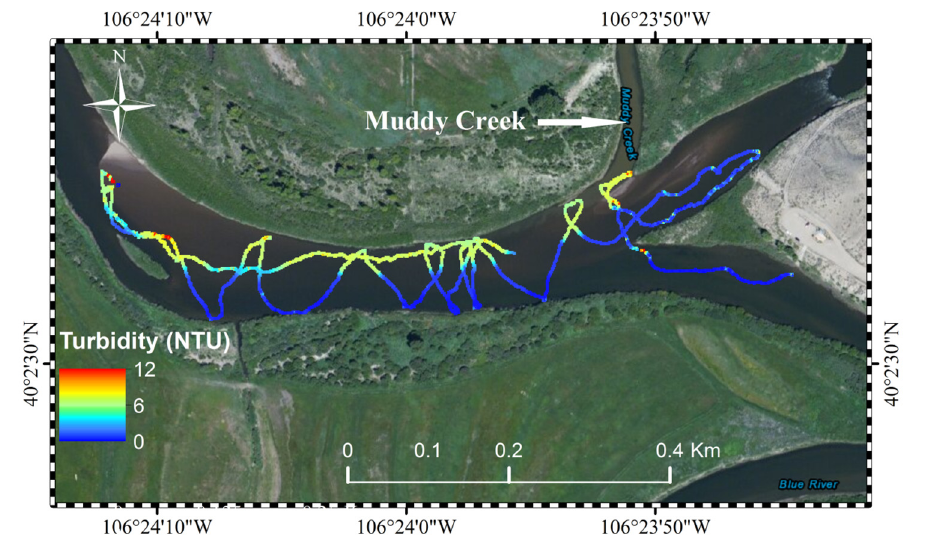
Figure 7. Turbidity measurements for the Blue/Colorado River (4663 measurements) with Muddy Creek entering from the